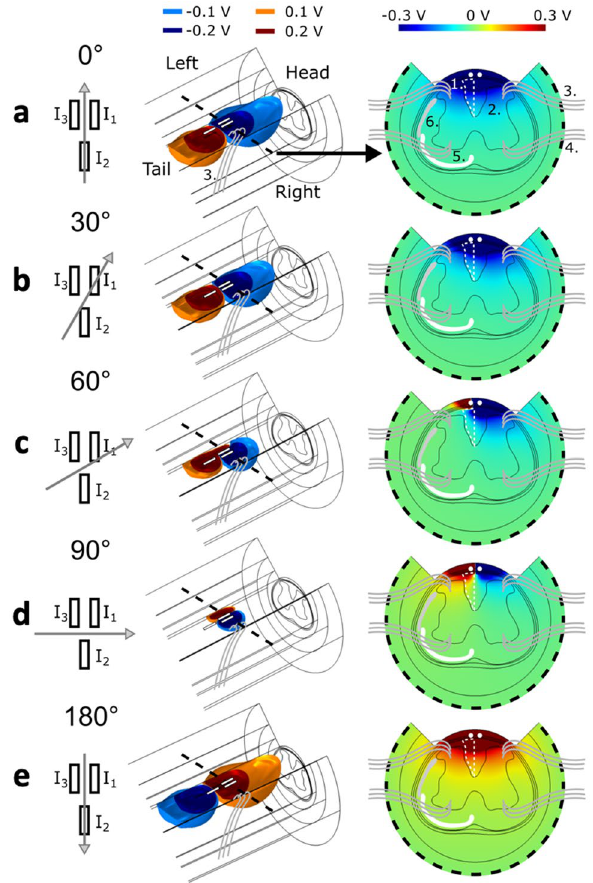
Figure 1. OS-ESCS in the rat spinal cord as seen by using finite element methods. The model was constructed based on Watson atlas using SolidWorks 2018 (Dassault Systèmes, Waltham, MA), after which the model was transferred to COMSOL 5.4 (COMSOL, Stockholm, Sweden) for simulations of electrical field potentials. The model included a section of an anatomically correct rat spinal cord surrounded by cylindrical layers of CSF, dura, epidural fat, muscle and bone. ( a – e ) The behavior of the electric potential field using different OS-ESCS stimulation angles is shown using electrode schematics representing the stimulation direction, 3D isosurfaces and 2D surface plots across the two rostral electrode contacts. I 1,2,3 in the first column correspond to the currents described by Eq. (1). The location of the main structures relevant to ESCS are illustrated in ( a ): 1. dorsal columns, 2. dorsal horn, 3. dorsal roots, 4. ventral roots, 5. Spinothalamic tract and 6. spinocerebellar